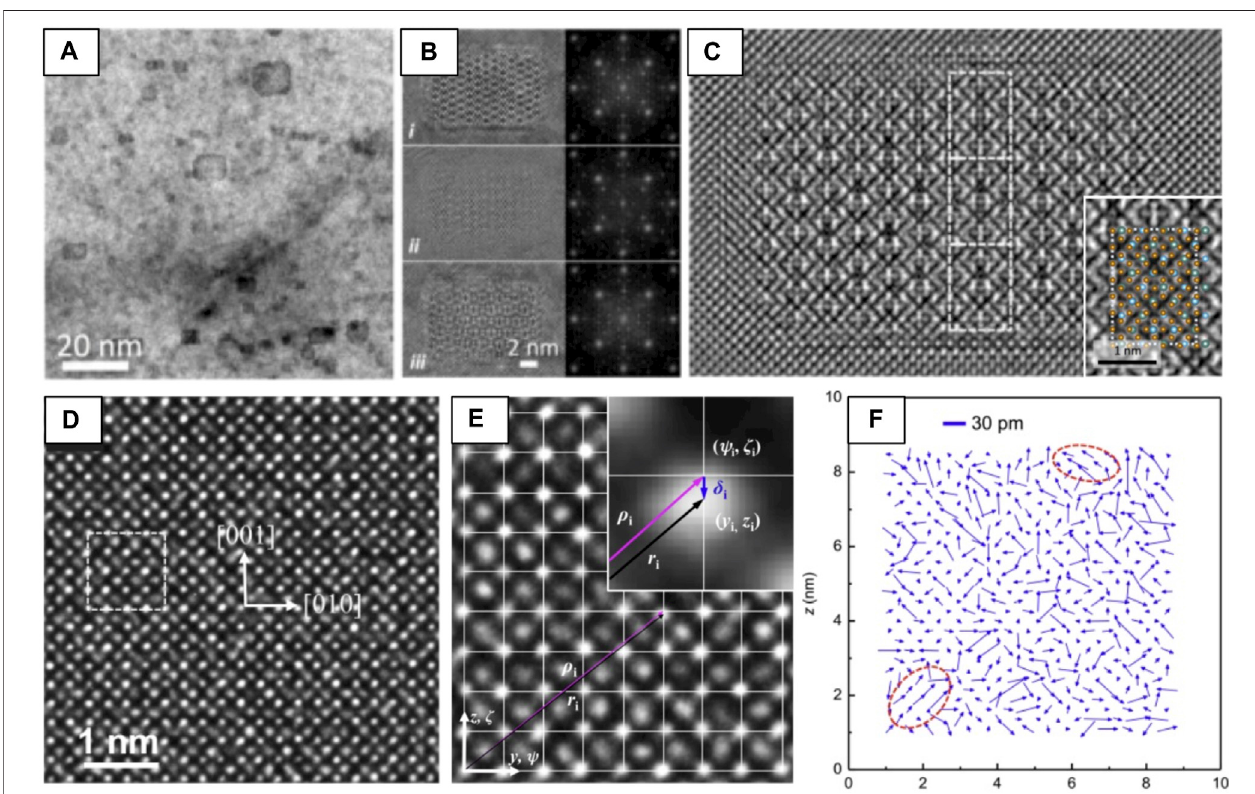
FIGURE 3 | Examples of two HRTEM imaging-based techniques, EWR (A – C) and NCSI (D – F) used to determine crystal structure and atomic displacive disorder, respectively. (A) BF-TEM of Y 2 Ti 2 O 7 nano-oxides in a NFA matrix. (B) i) underfocused, ii) focused, and iii) overfocused HRTEM images and fast-Fourier transforms (FFTs) of the nano-oxides. (C) Reconstructed electron wave phase obtained from EWR with white atom contrast and a simulated Y 2 Ti 2 O 7 structure overlaid on a magni fi ed view of the EWR (inset),reproducedfrom(Wuetal.,2016). (D) HRTEMofa[100]BZNpyrochloretakenunderNCSIconditions,dottedlinesoutlineaunitcell. (E) Determinationoftheatomic displacementvector δ i fromNCSIimages,whitelinecrossingsindicatetheaveragecationpositionsoftheidealpyrochlore. (F) Mapofshiftvectorsbetweenthecenterofgravityof the A-site and the ideal A-site cation position, red circles outline the presence of nanoregions ( ∼ 2 nm) of correlated A-type atomic shifts, reproduced from (Jia et al., 2018).